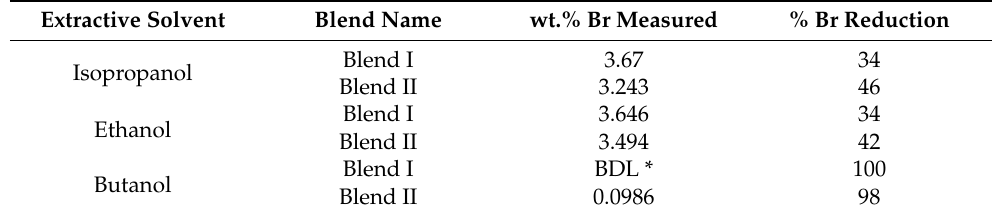
Table 2. Bromine content after applying a 6 h soxhlet extraction using different extractive solvents. Extractive Solvent Blend Name Isopropanol Ethanol Blend Butanol